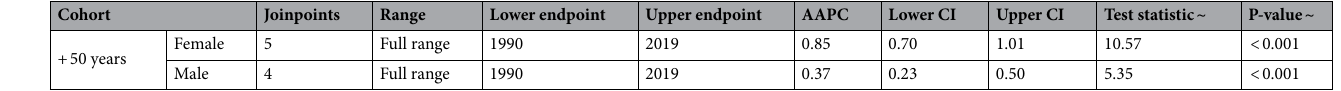
Table 2. Descriptive statistics of mortality due to ambient particulate matter exposure separated by gender.